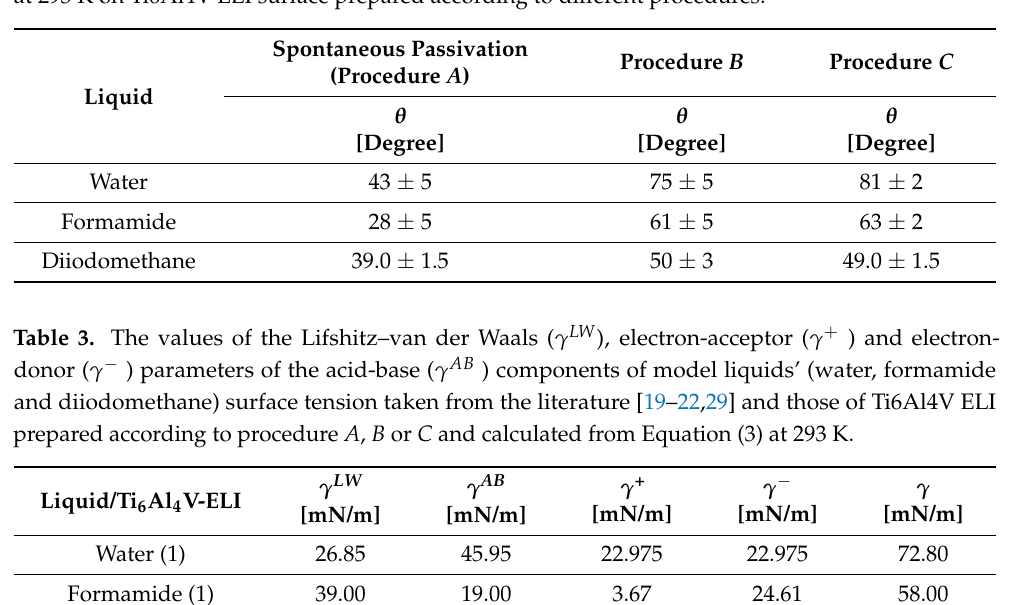
Table 2. The average values of the contact angle ( θ ) of water, formamide and diiodomethane measured at 293 K on Ti6Al4V ELI surface prepared according to different procedures.